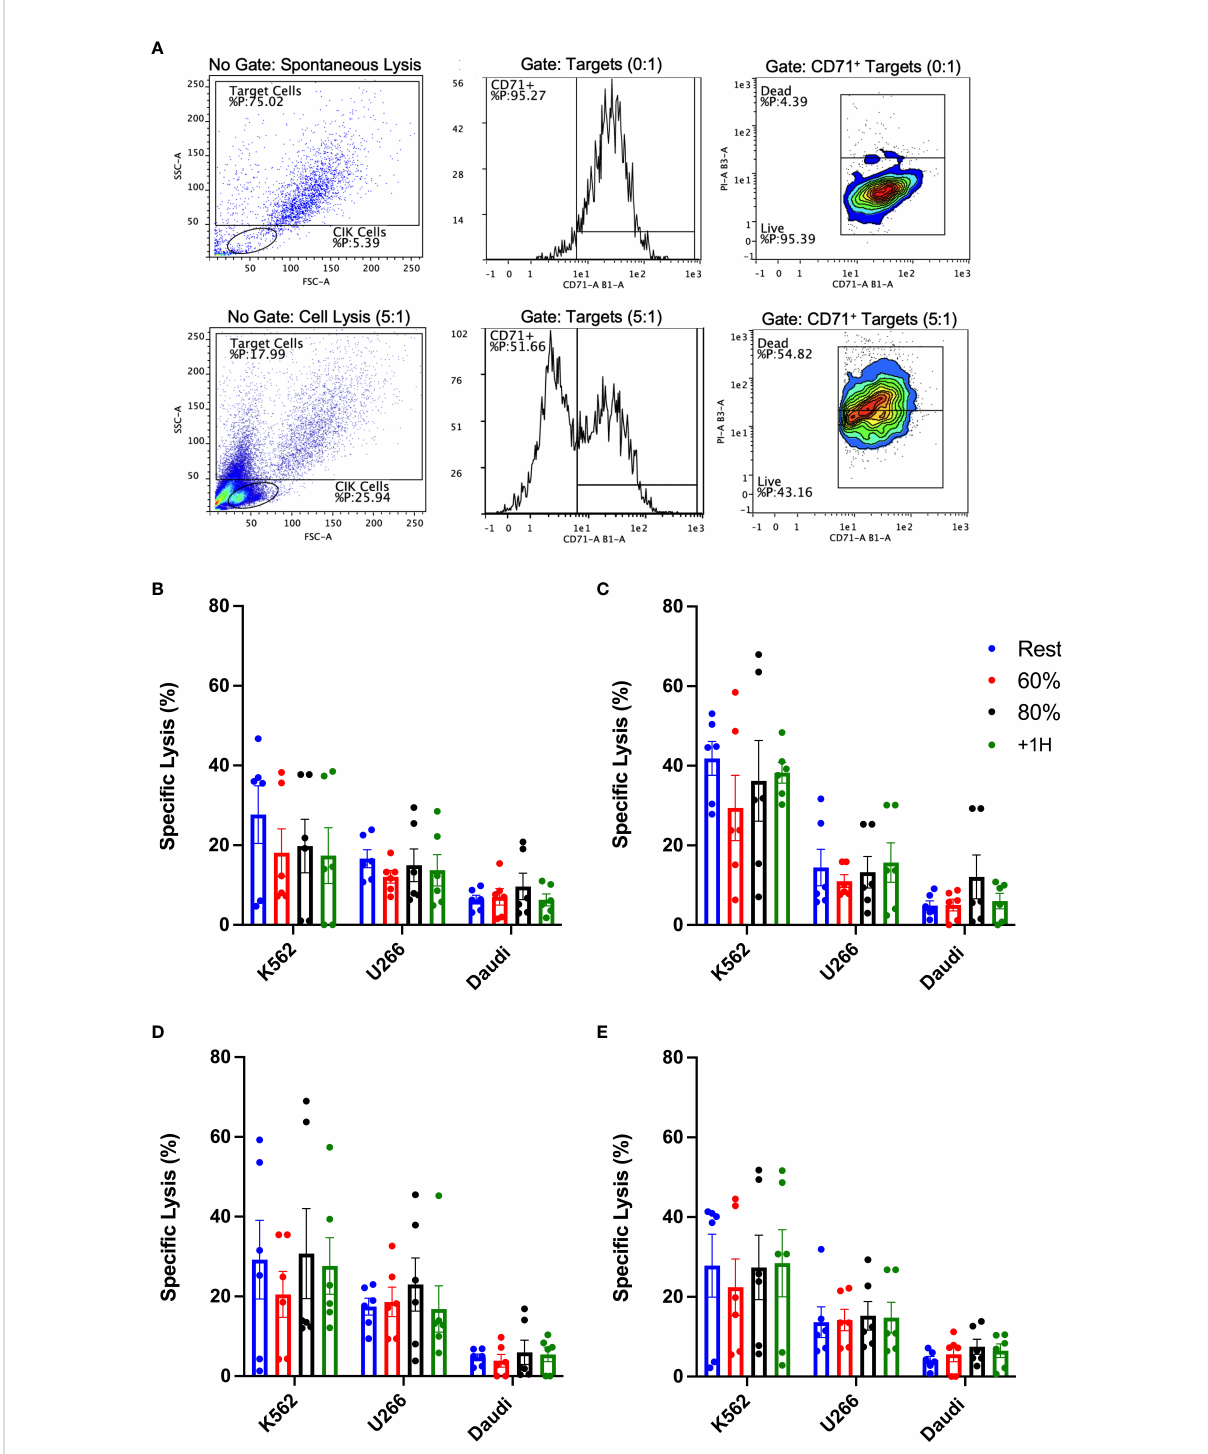
FIGURE 7 Exercise and cytokine stimulation does not augment anti-tumor activity of CIK cells against various cell targets in vitro. Cytotoxicity of CIK cells was assessed via fl ow cytometry-based assays against K562, U266, and Daudi cells at a E:T ratio of 5:1 ( n = 6). (A) Representative fl ow cytometry plots illustrate the gating strategy utilized to determine speci fi c lysis (CD71 + /PI + ). Expanded CIK cells were stimulated in (B) media alone or media supplemented with (C) 300IU/mL IL-2, (D) 5 ng/mL OKT-3, or (E) a combination of IL-2 and OKT-3. Error bars are represented as mean ± SEM. There were no signi fi cant differences found in lytic function between exercise